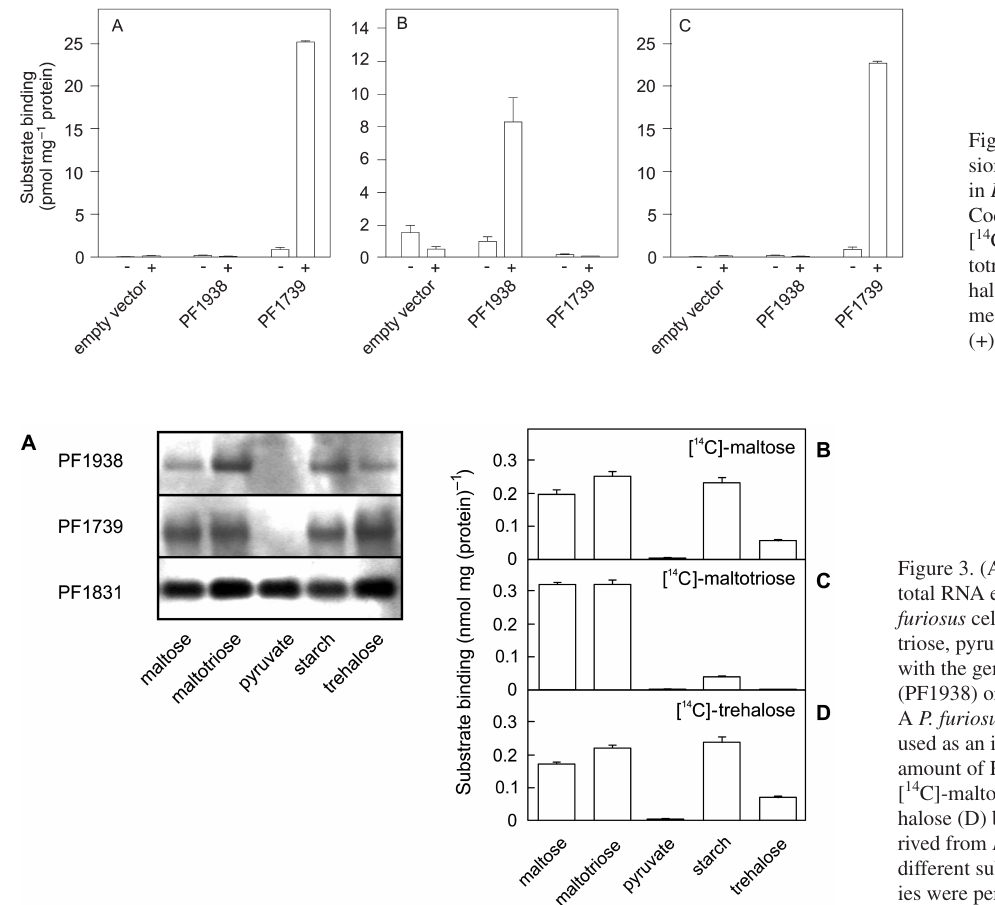
tive binding proteins did not match completely in a reproduc- ible way. Taken together, the results suggest that both TMBP